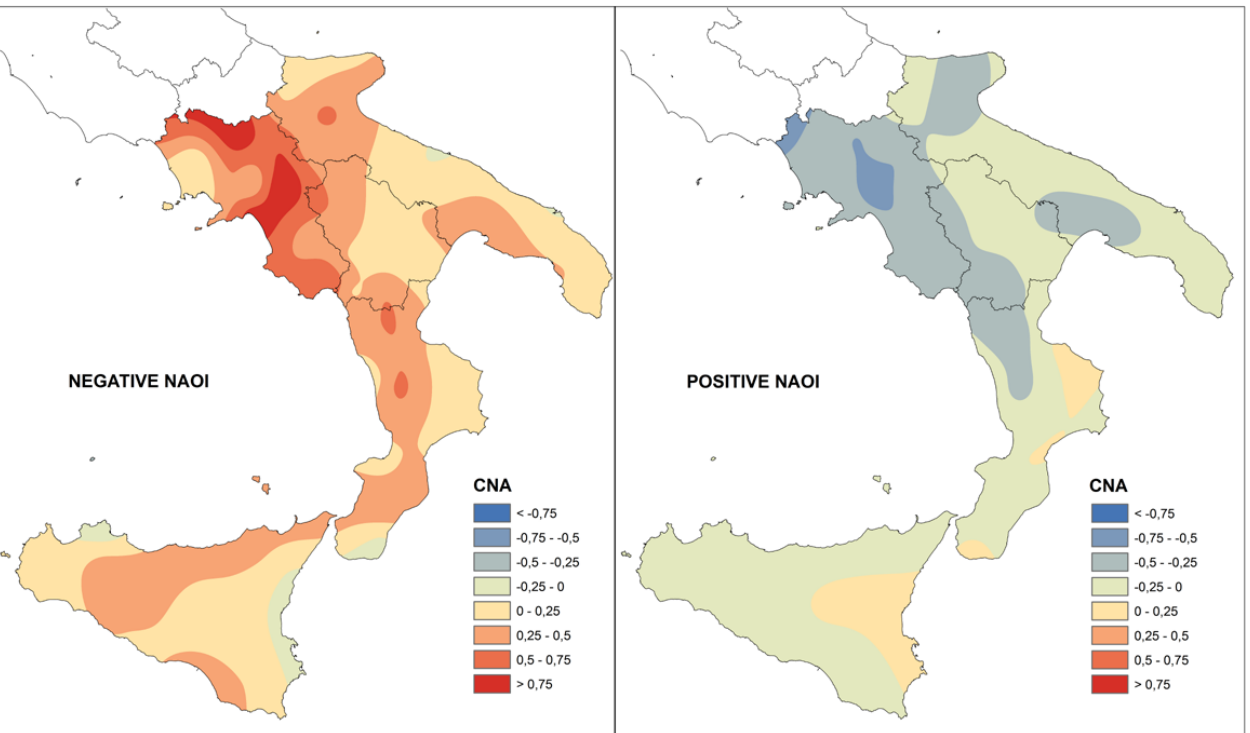
Fig. 8. Spatial distribution of the CNA for the winter precipitation, with reference to both the extreme negative phase ( < − 1) and extreme positive phase ( > 1) of the NAOI.